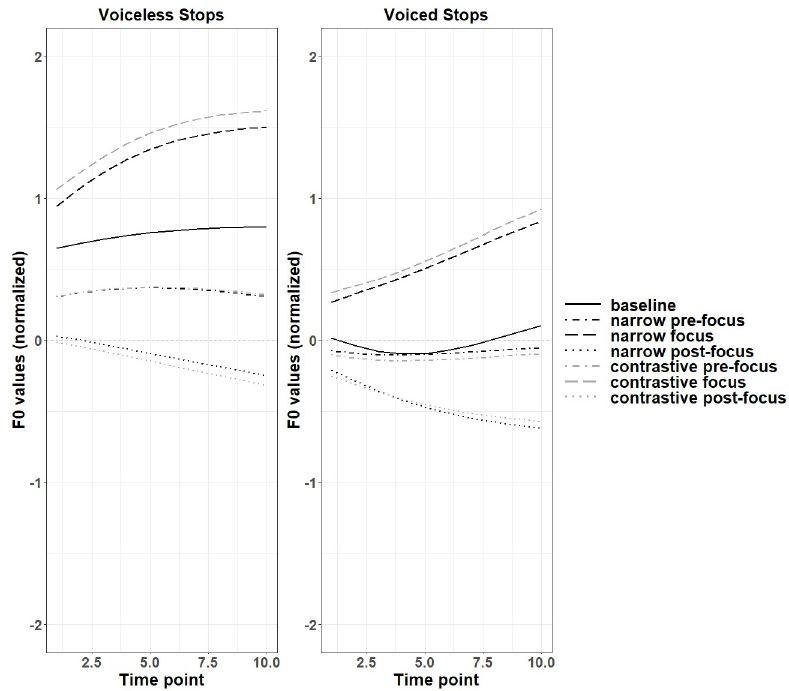
Fig 4. Normalized f0 contours of monosyllabic targets across various discourse conditions (Japanese).